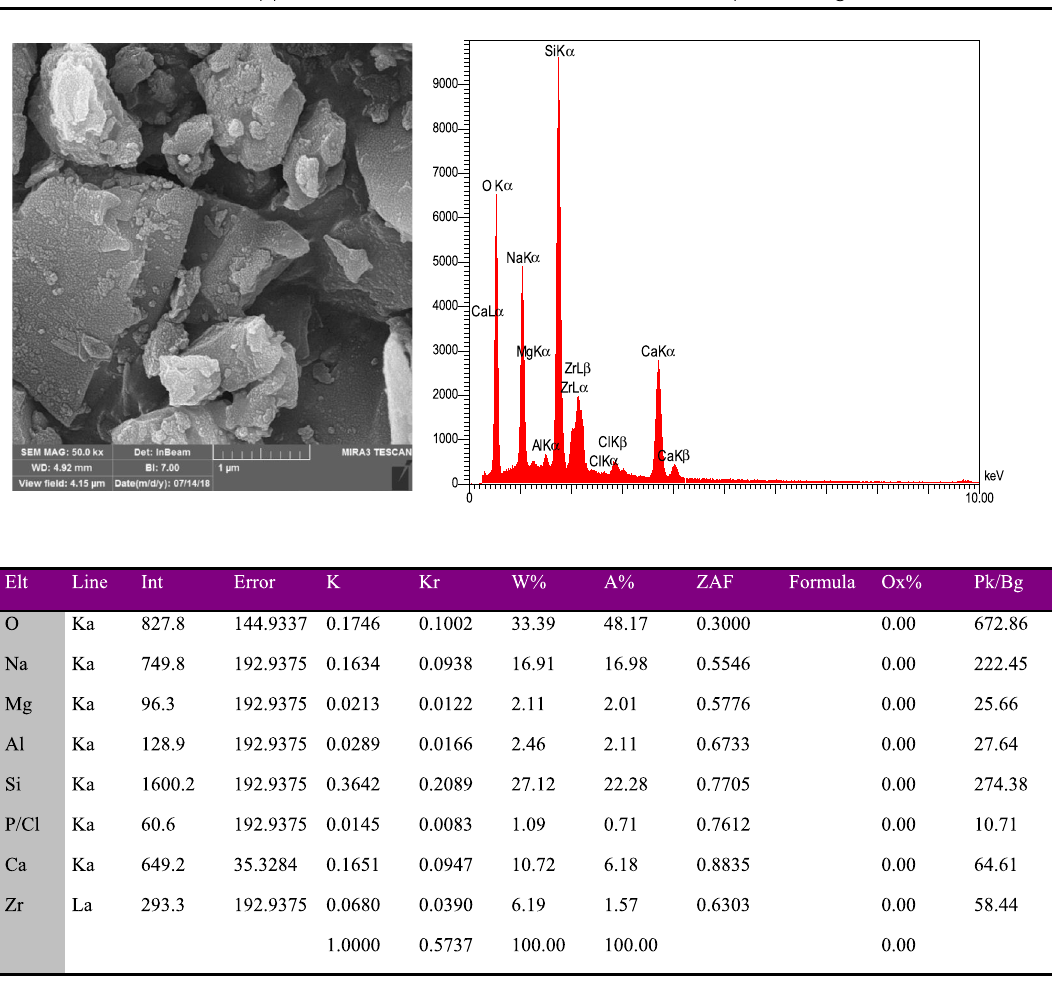
Fig. 2 The FE-SEM of the bioactive glass powder with the EDS results